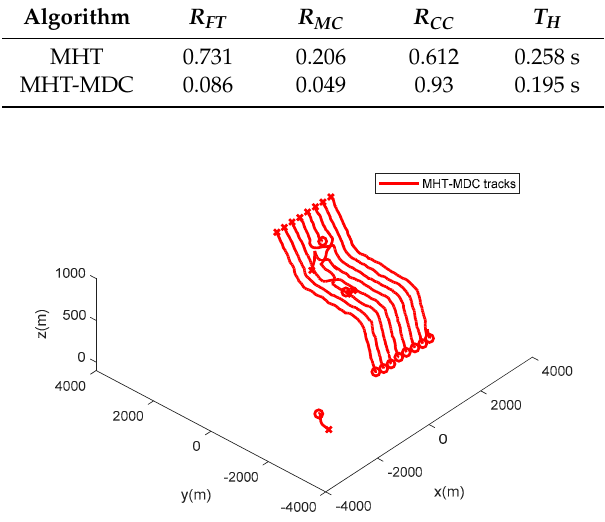
Figure 11. The estimated trajectories of the MHT-MDC in scenario 2.